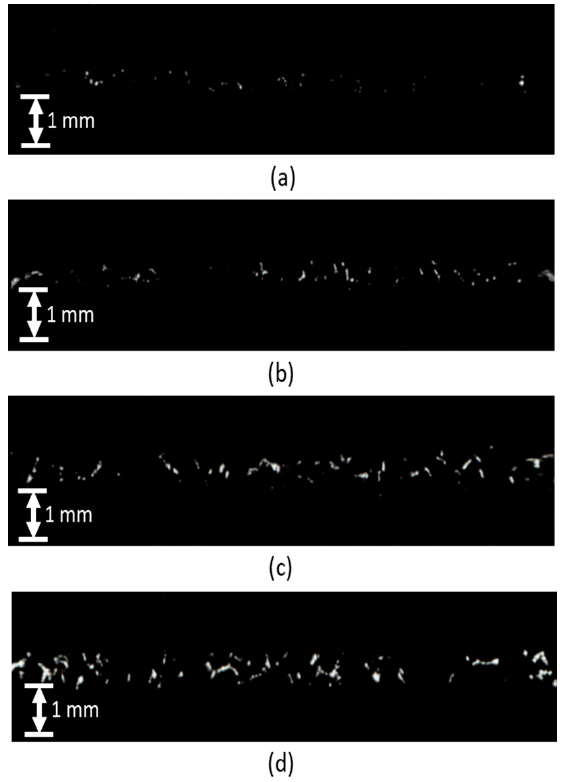
Figure 10. Contact footprint of grinding wheel WA60J8V, d s = 195 mm, d w = 98 mm, b = 20 mm. ( a ) 1 N / mm; ( b ) 2.5 N / mm; ( c ) 5 N / mm; ( d ) 10 N /